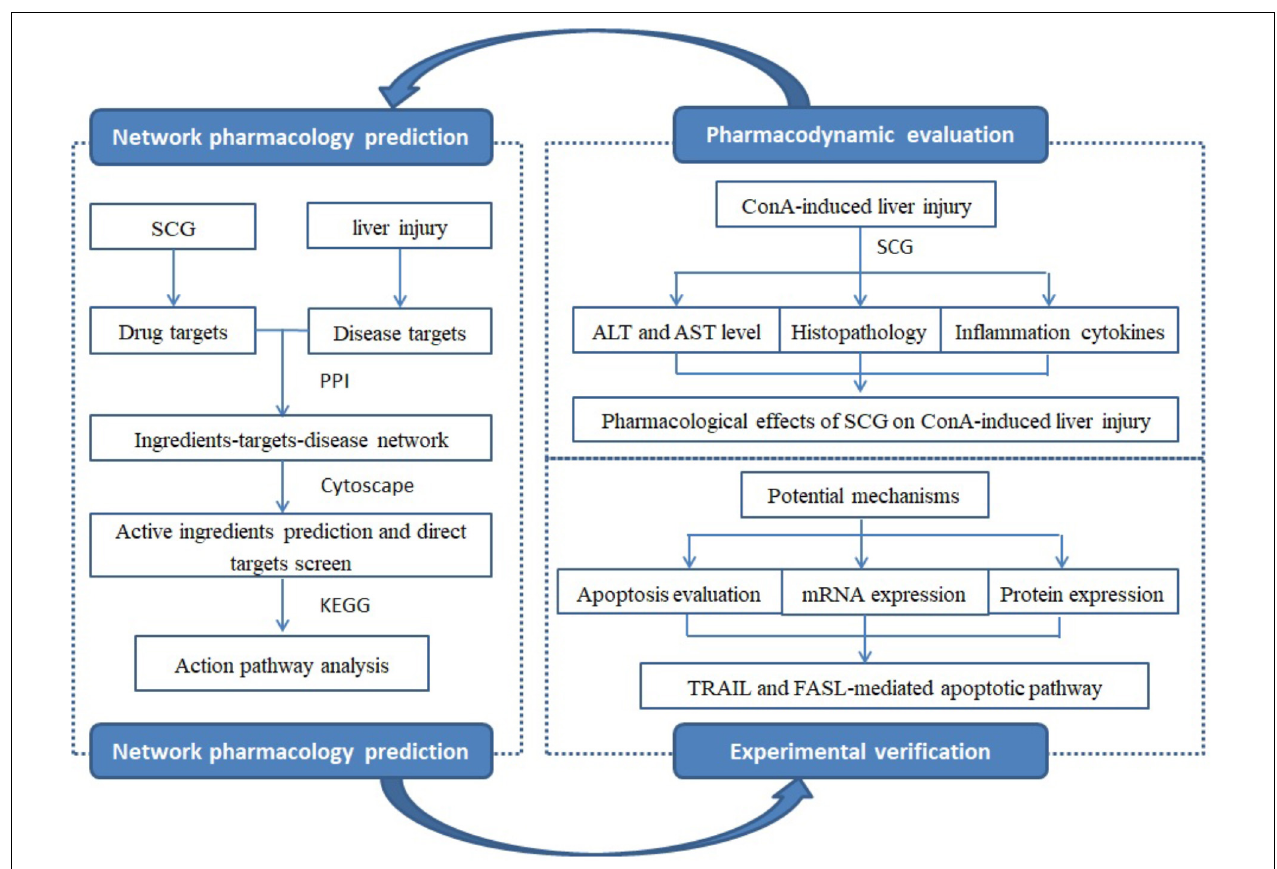
FIGURE 1 | The framework of the present